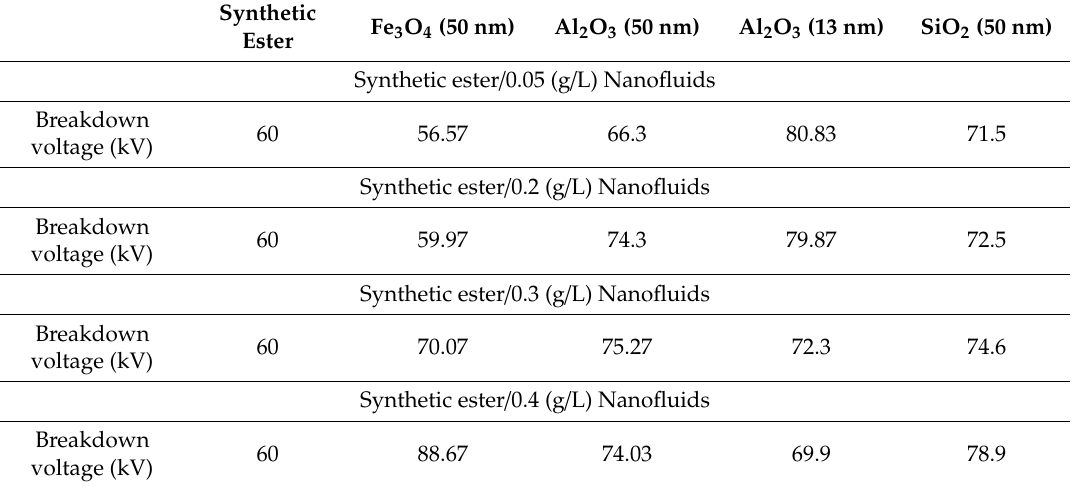
Table 5. Mean value of AC-BDV of di ff erent synthetic ester (MIDEL 7131)—based nanofluids